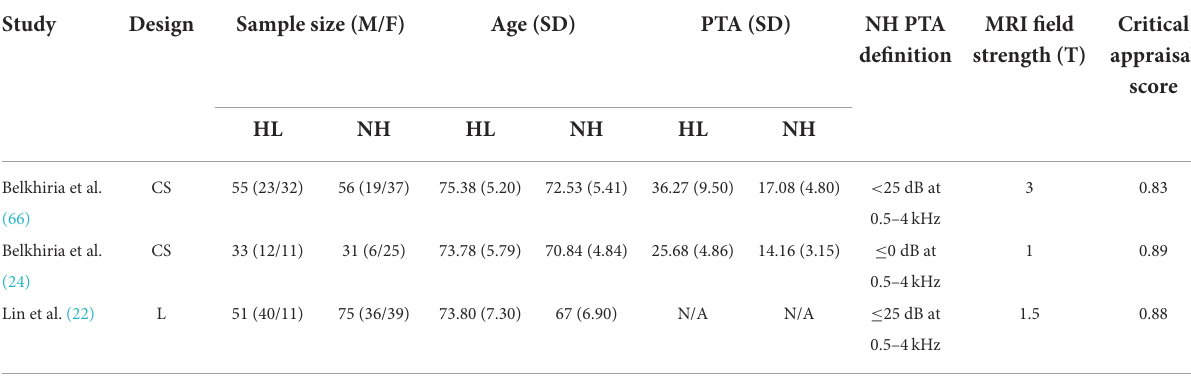
TABLE 4 Means, and standard deviations where applicable, of the data extracted for papers used in the lobe-wise analyses.